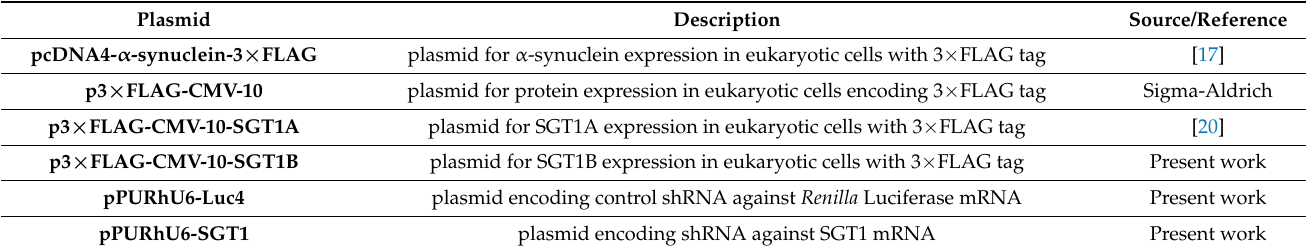
Table 1. List of plasmids used for transfection of HEK293